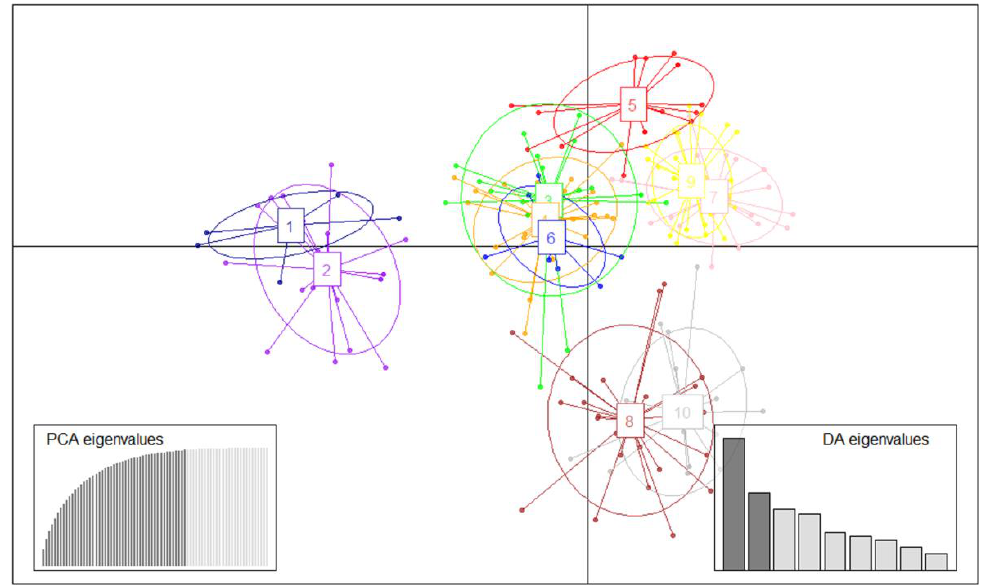
Figure 3. Scatterplot of DAPC of 202 apricot accessions, showing the first two principal linear discriminants of the DAPC according to the optimal K value (K = 10). Each circle represents a group and each dot represents an accession. The groups are depicted in dark blue (G1), in purple (G2), in green (G3), in orange (G4), in red (G5), in blue (G6), in pink (G7), in brown (G8), in yellow (G9), and in grey (G10).The insets represent the eigenvalues of the Principal Component Analysis (PCA) and Discriminant Analysis (DA).